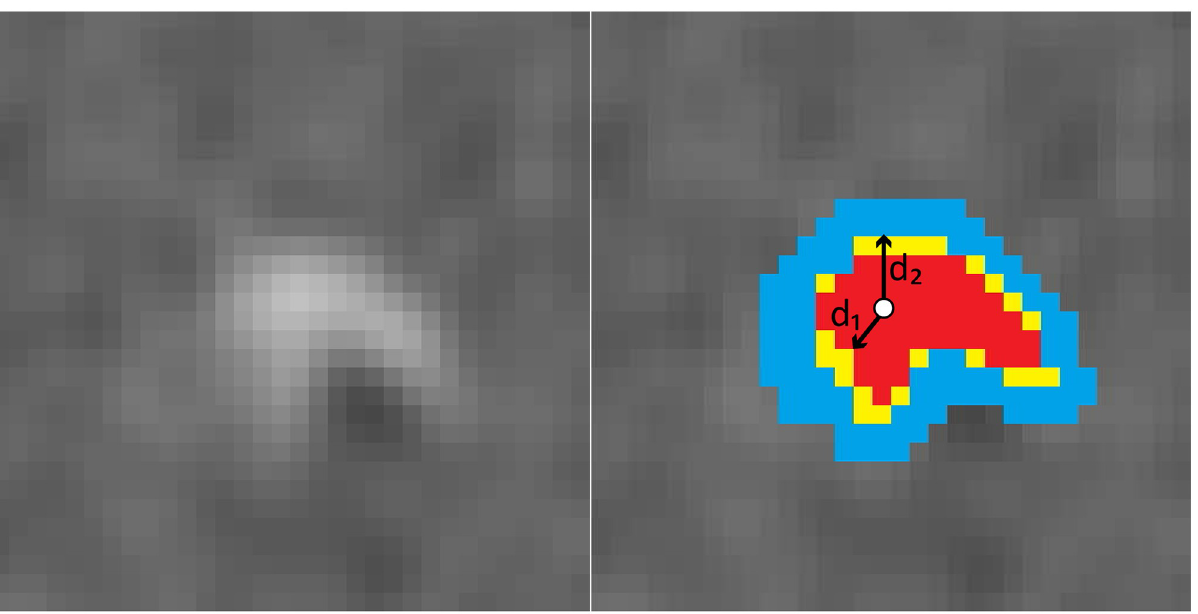
Fig 3. CAC segmentation using PVC-CS: Left: CT image containing calcified lesion; Right: Initial calcification volume obtained by intensity value thresholding at 130 HU (red); Refined extended calcification segmentation obtained by intensity value thresholding at 90 HU filtered with the distance transform (yellow); CAC background